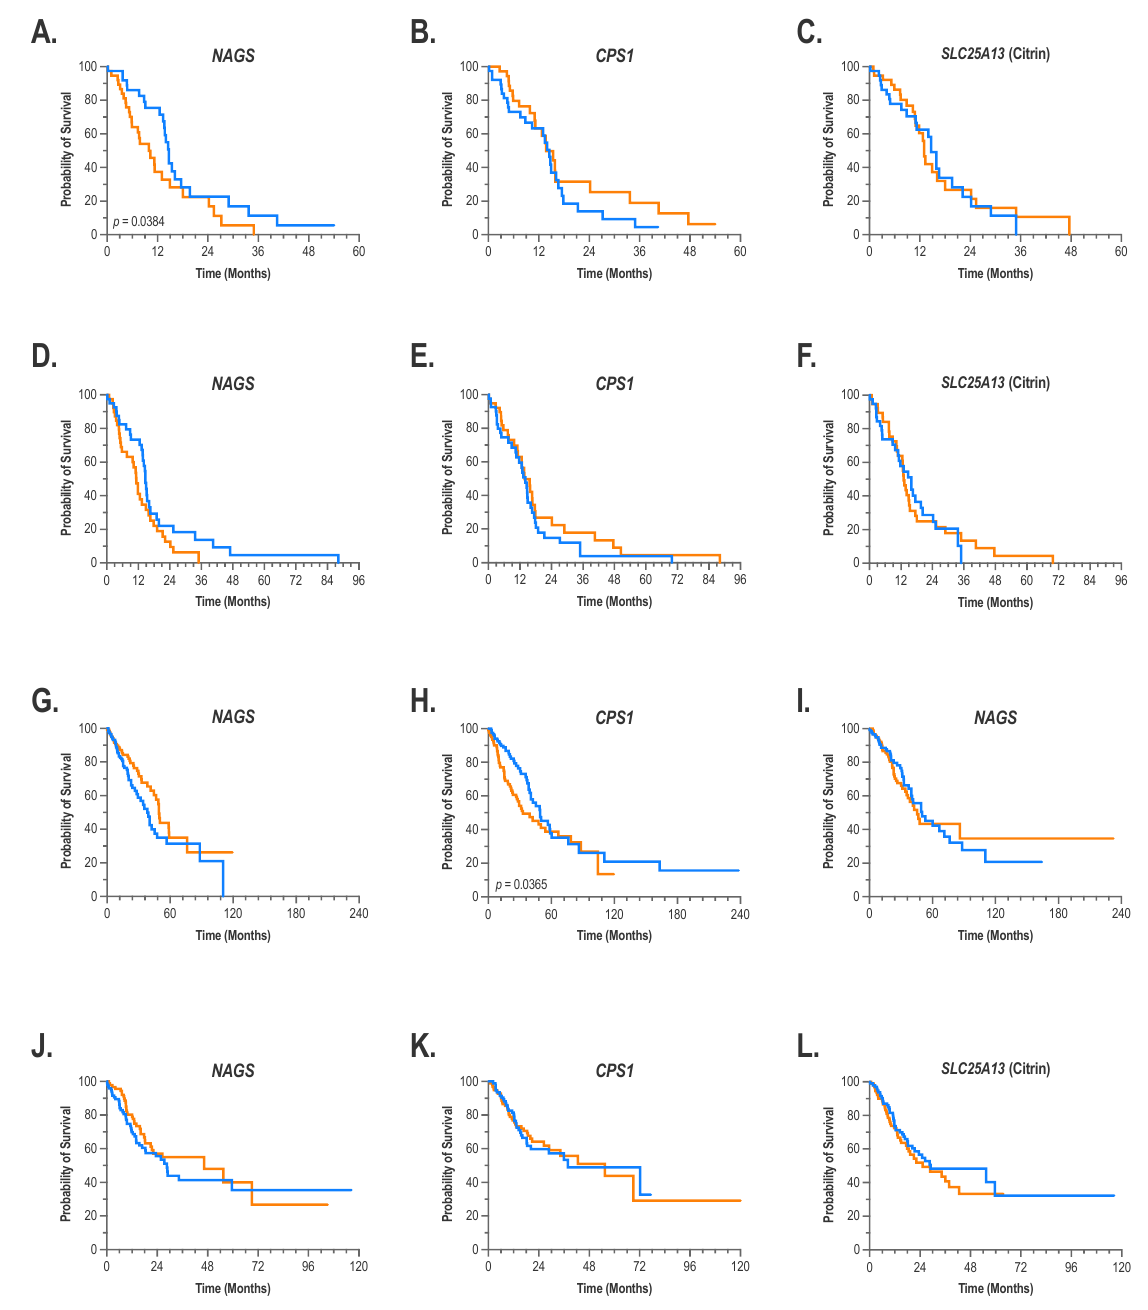
Figure 2. Association between expression of NAGS , CPS1, and citrin mRNA in tumors and patient outcomes. Kaplan–Meier curves showing survival of patients with glioblastoma ( A – C ), glioblastoma multiforme ( D – F ), lung adenocarcinoma ( G – I ) and stomach adenocarcinoma ( J – L ), exhibiting highest and lowest levels of NAGS , CPS1 , and citrin mRNA expression. Orange–tumors in the highest quartile of mRNA expression; blue–tumors in the lowest quartile of mRNA expression.